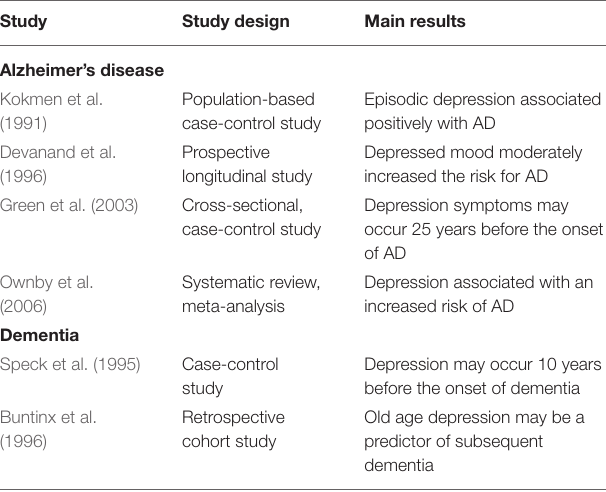
TABLE 4 | Studies investigating the association between depression, dementia, and